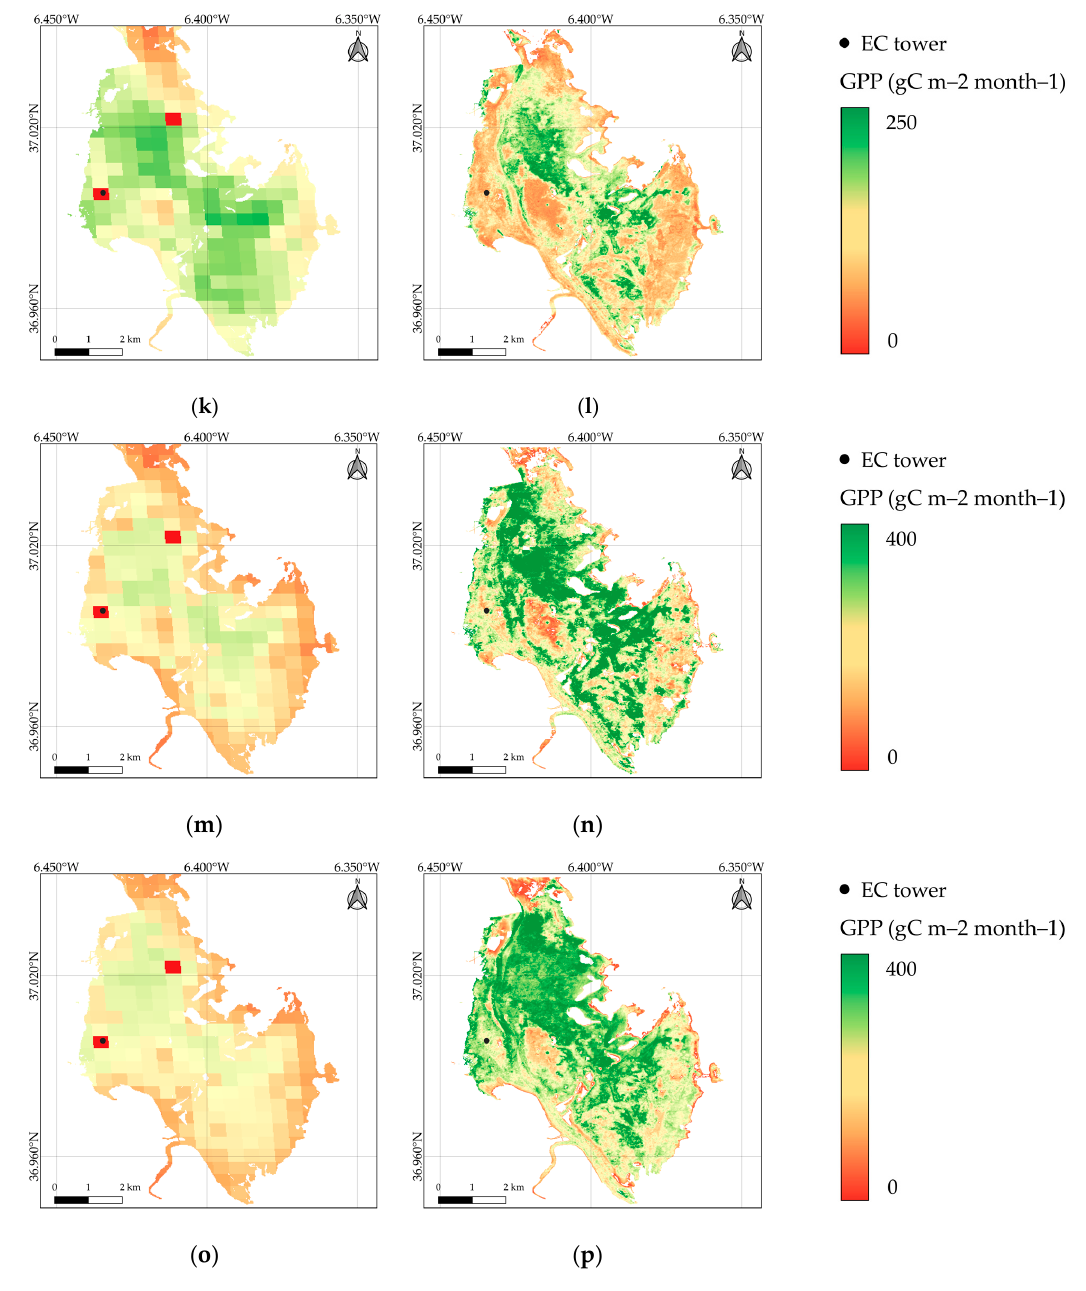
Figure A1. Comparison of Sentinel-2 (S2) and MOD17 GPP maps obtained using a monthly composite image. The maps show the spatial and temporal pattern of GPP (gC m − 2 month − 1 ) and the difference captured by the two satellites given their different spatial resolution. ( a ) MOD17 October 2020, ( b )